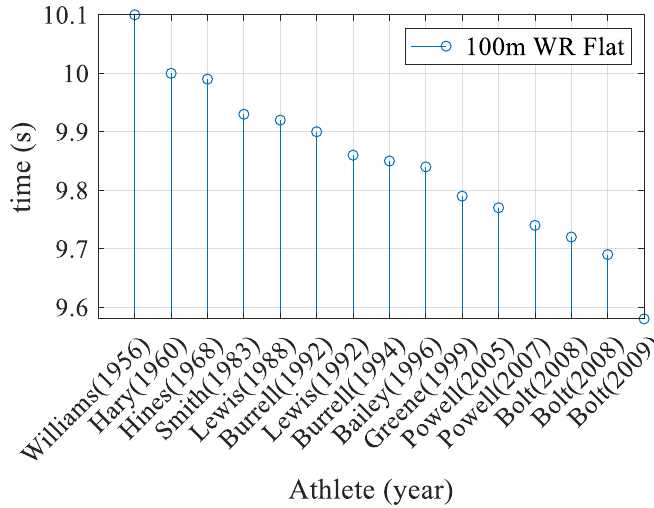
Figure 1. Progress of the 100 m sprint world record.